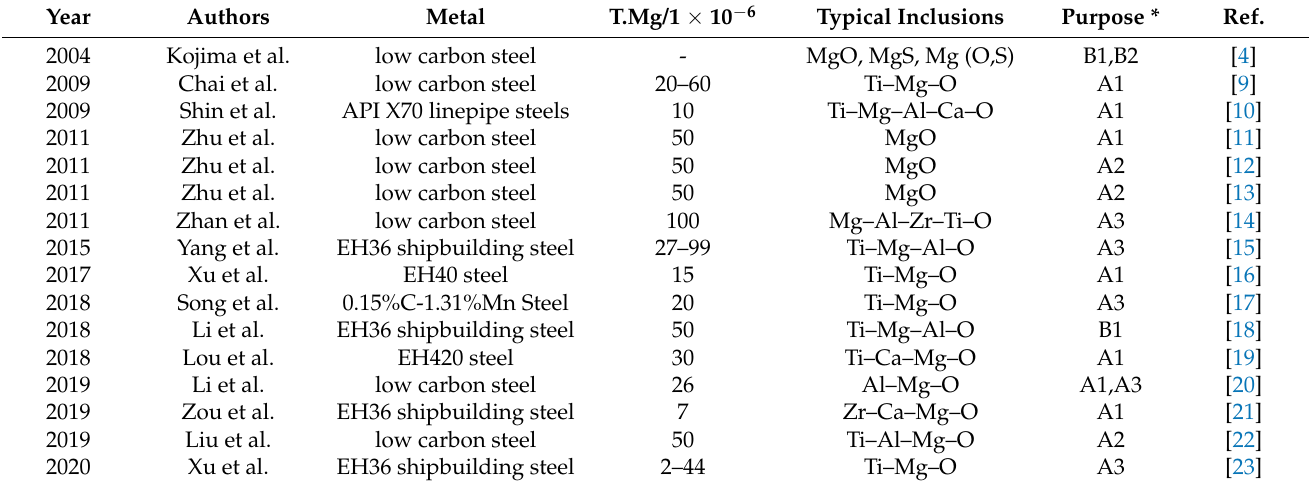
Table 1. Typical investigations concerning the effect of Mg addition on HAZ in past two